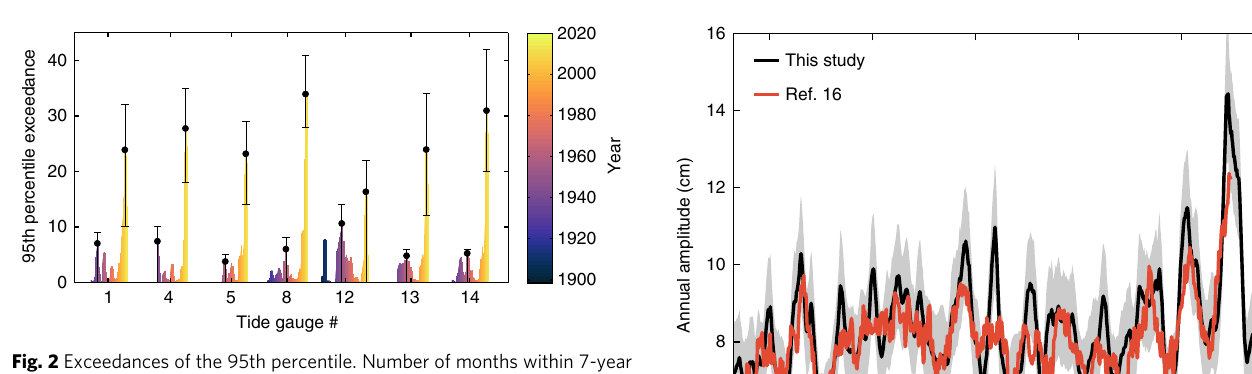
Fig. 2 Exceedances of the 95th percentile. Number of months within 7-year running windows for which the amplitude of the SLAC is above the 95th percentile (computed over the entire record) for tide-gauge records with at least 50 years of data. To construct the histogram, a 7-year window is shifted month by month starting with a window centered at month 43 of the record. Numbers along the x axis refer to the identi fi cation numbers shown in Fig. 1, while colors correspond to the color bar and denote time. The two error bars in each histogram represent the 68% credible intervals associated with the maximum values in 2008 – 2009 and in the period before 1990, whereas the black dots represent such maximum values